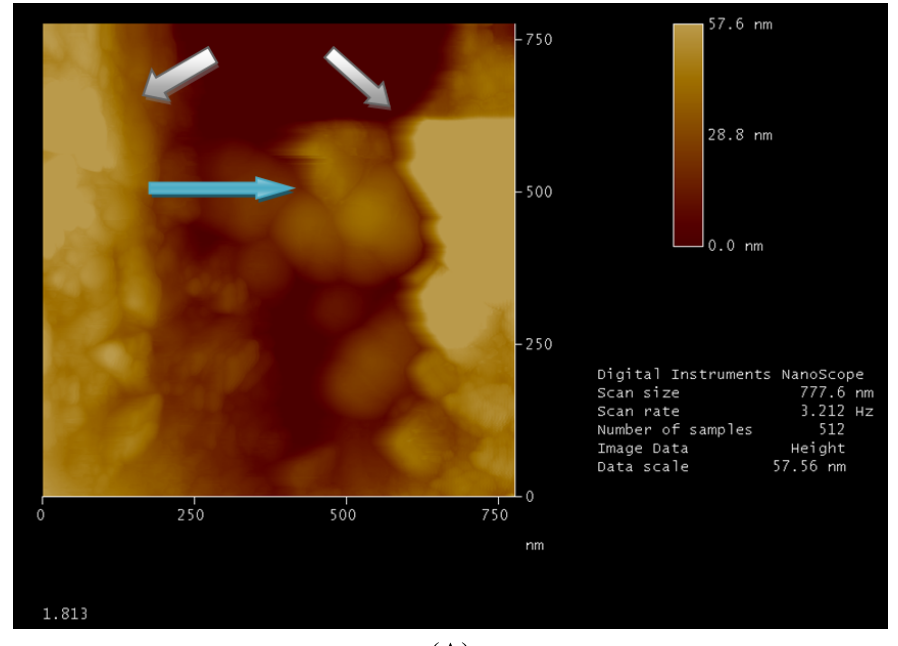
Figure 2. Atomic force microscopy (AFM) image obtained by “tapping mode”.